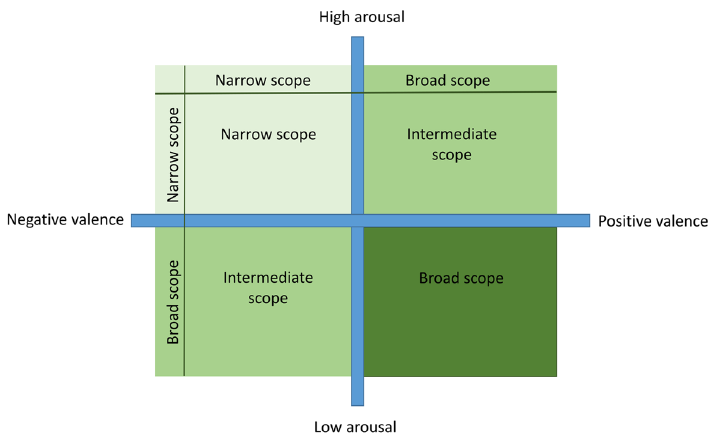
Figure 1. Predictions for the narrowing or broadening of attentional scope within the two-dimensional animal emotional state framework consisting of a valence and arousal